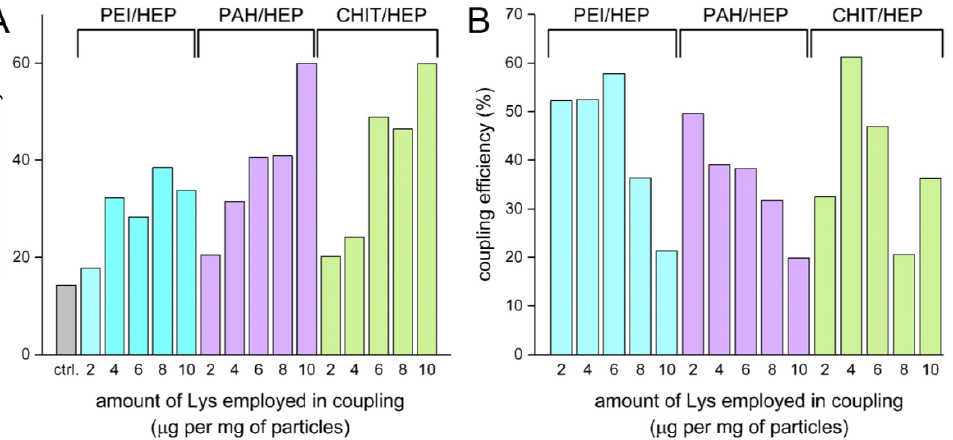
Figure 9. ( A ) Fluorescence intensity derived from immobilized FITC tagged Lys and ( B ) coupling efficiency of reactions carried out with different Lys